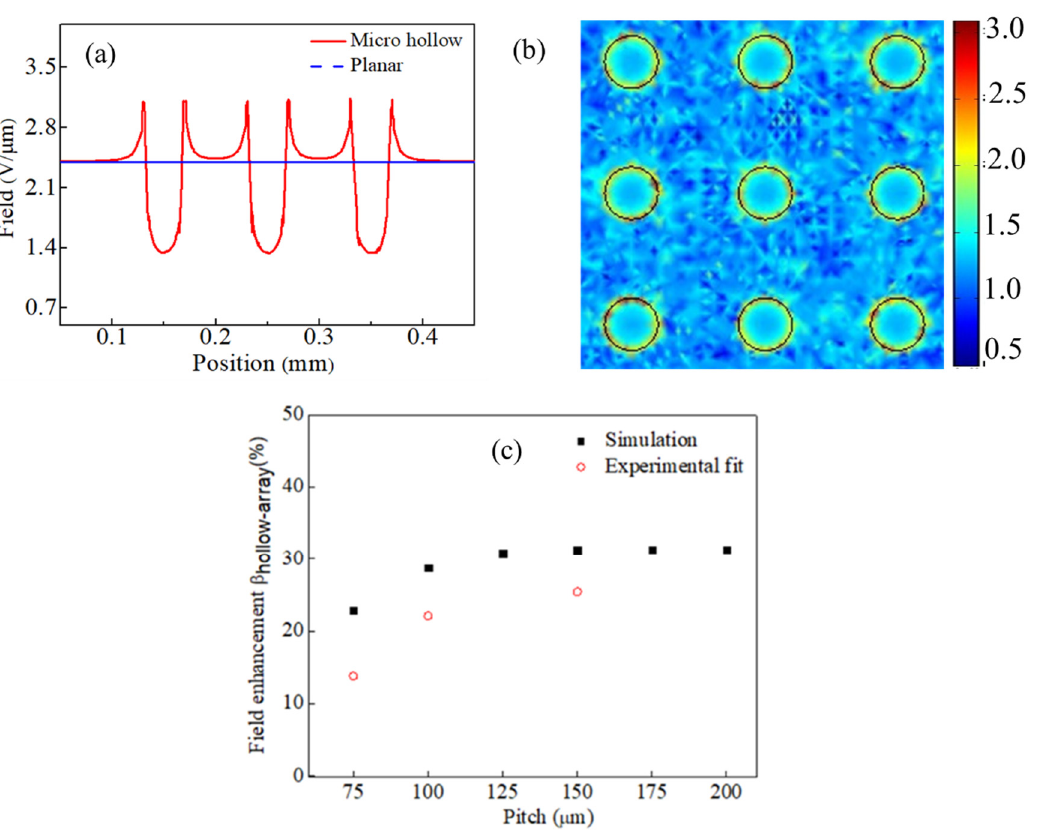
Figure 4. ( a ) Electric field distribution on three consecutive hollows (along centerpiece cross-section line), a maximum field at rim edges. ( b ) Contour plots of a local electric field (false color plots in V/µm scale) of 3 × 3 hollow (diameter of 40 µm, a pitch of 100 µm, depth of 200 µm), demonstrates a variation of electric field for the ( c ) simulated cathode field enhancement as a function of pitch .